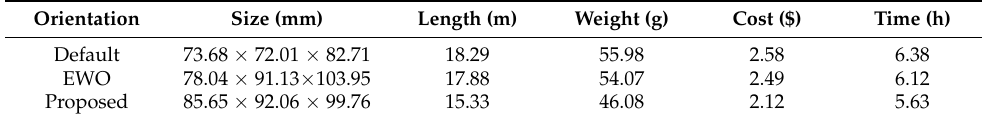
Table 3. Volume error comparison in different methods.